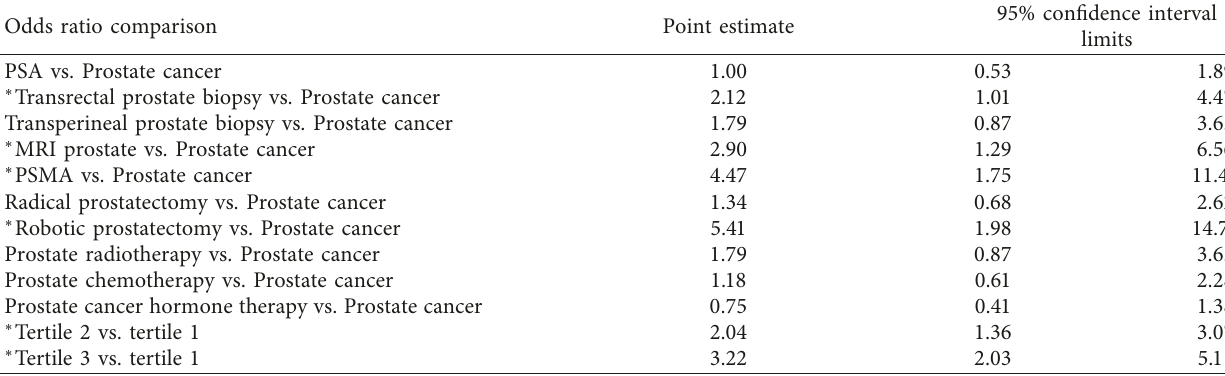
Table 2: Univariate logistic regression analysis showing odds ratio estimates comparing search terms to “Prostate cancer” and tertiles 2 and 3 against tertile 1.